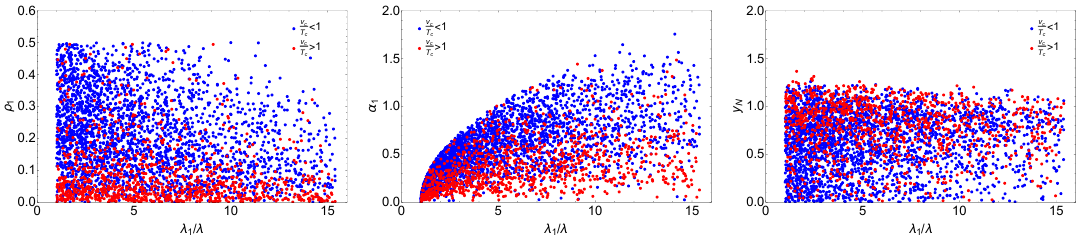
Figure 9 . Scatter plots of λ 1 /λ and ρ 1 (left), α 1 (middle) and y N (right), with the blue points have v 1 and the red ones v 1 c /T c < c /T c >